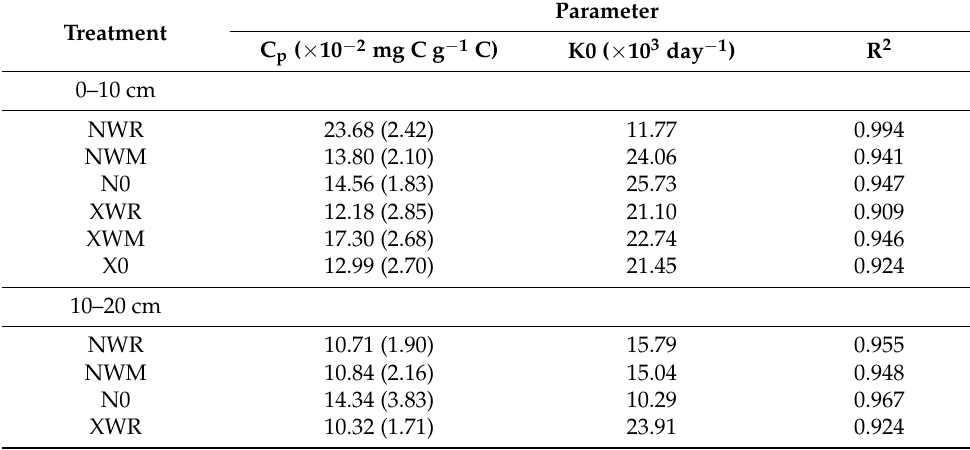
Table 5. Values of the parameters obtained for the carbon mineralization model (single-exponential model) fitted to the cumulative carbon mineralization data for the field experiments (soil samples without straw